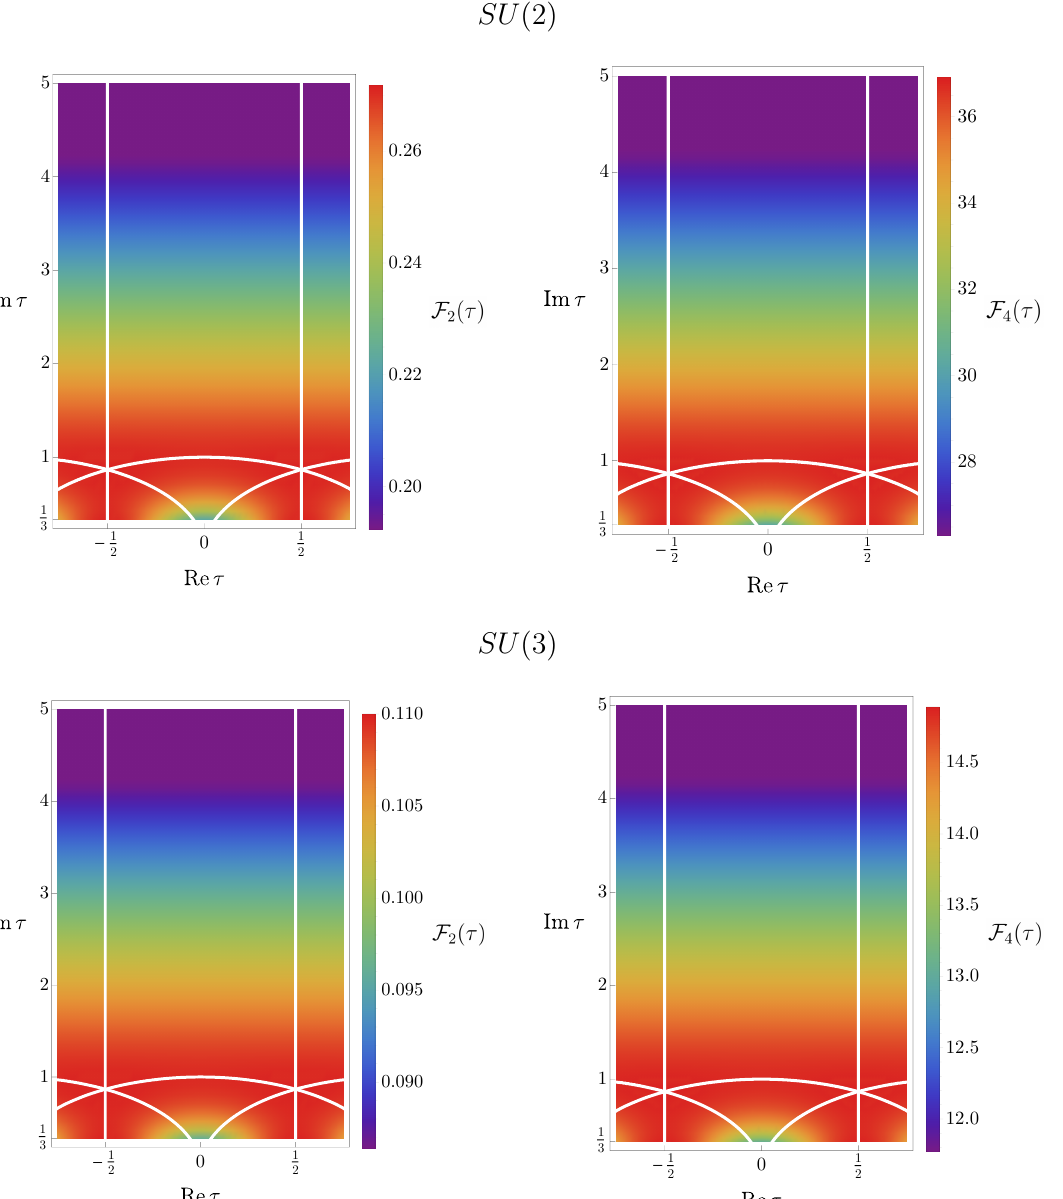
Figure 1 . The localization inputs for SU (2) and SU (3) as a function of the complex coupling τ . White lines show boundaries between some of the fundamental domains of SL (2 , Z ) . We compute these within the standard fundamental domain | z | > 1 , |< z | ≤ 1 using terms with up to 10 instantons 2 in (2.19) for SU (2) , and terms with up to 2 instantons for SU (3) , and extend by SL (2 , Z ) invariance to the remainder of the upper